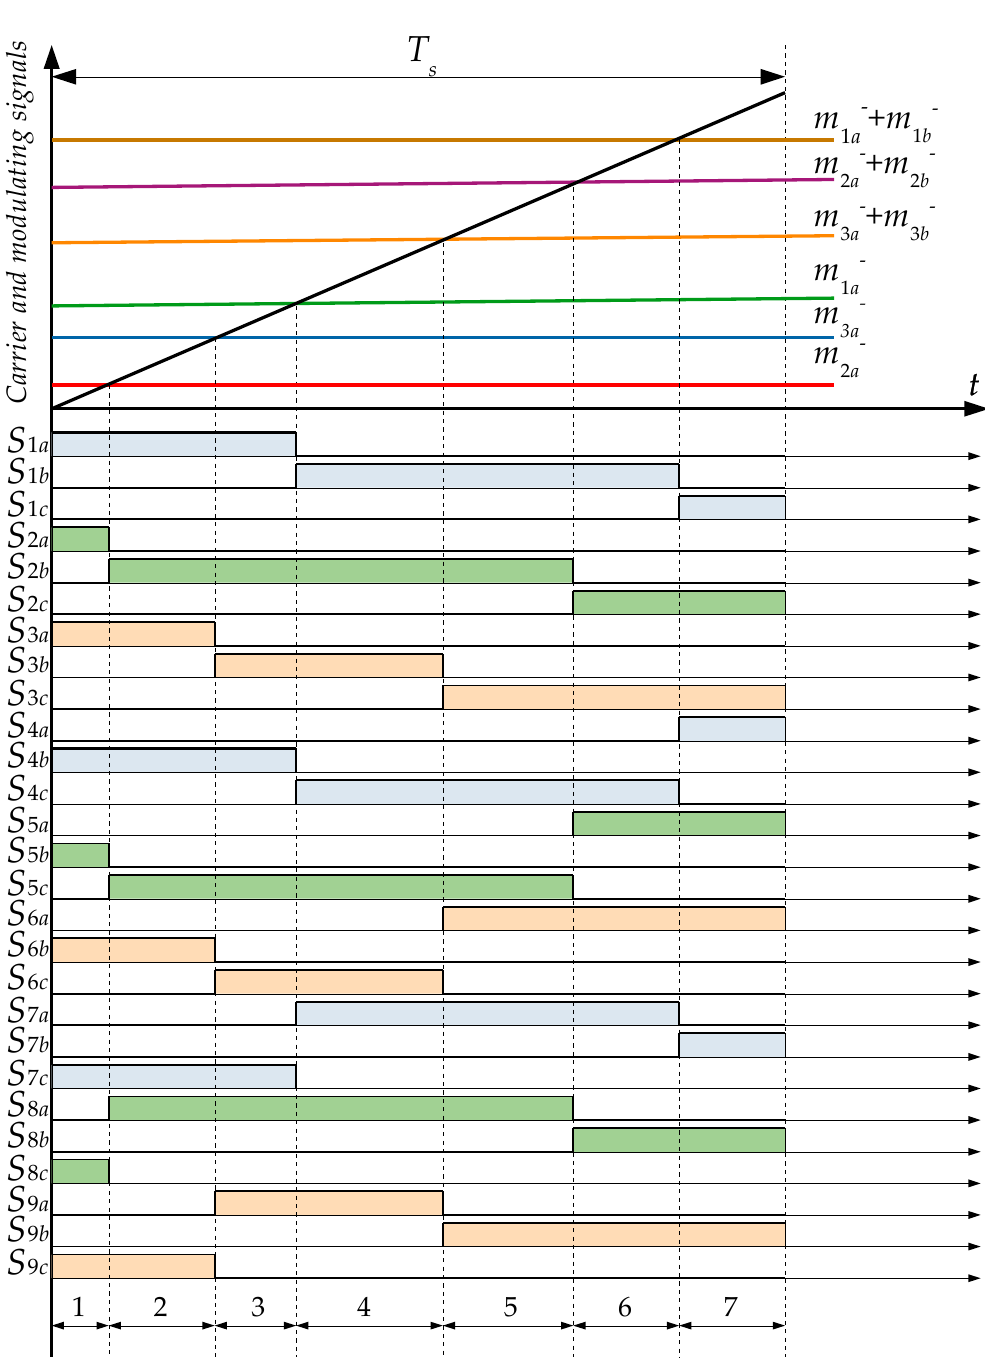
→ → → → → → V aaabbbccc , V ababcbcac , V abbbcccaa , V bbbcccaaa , V bbcccaaab , V bcccaaabb